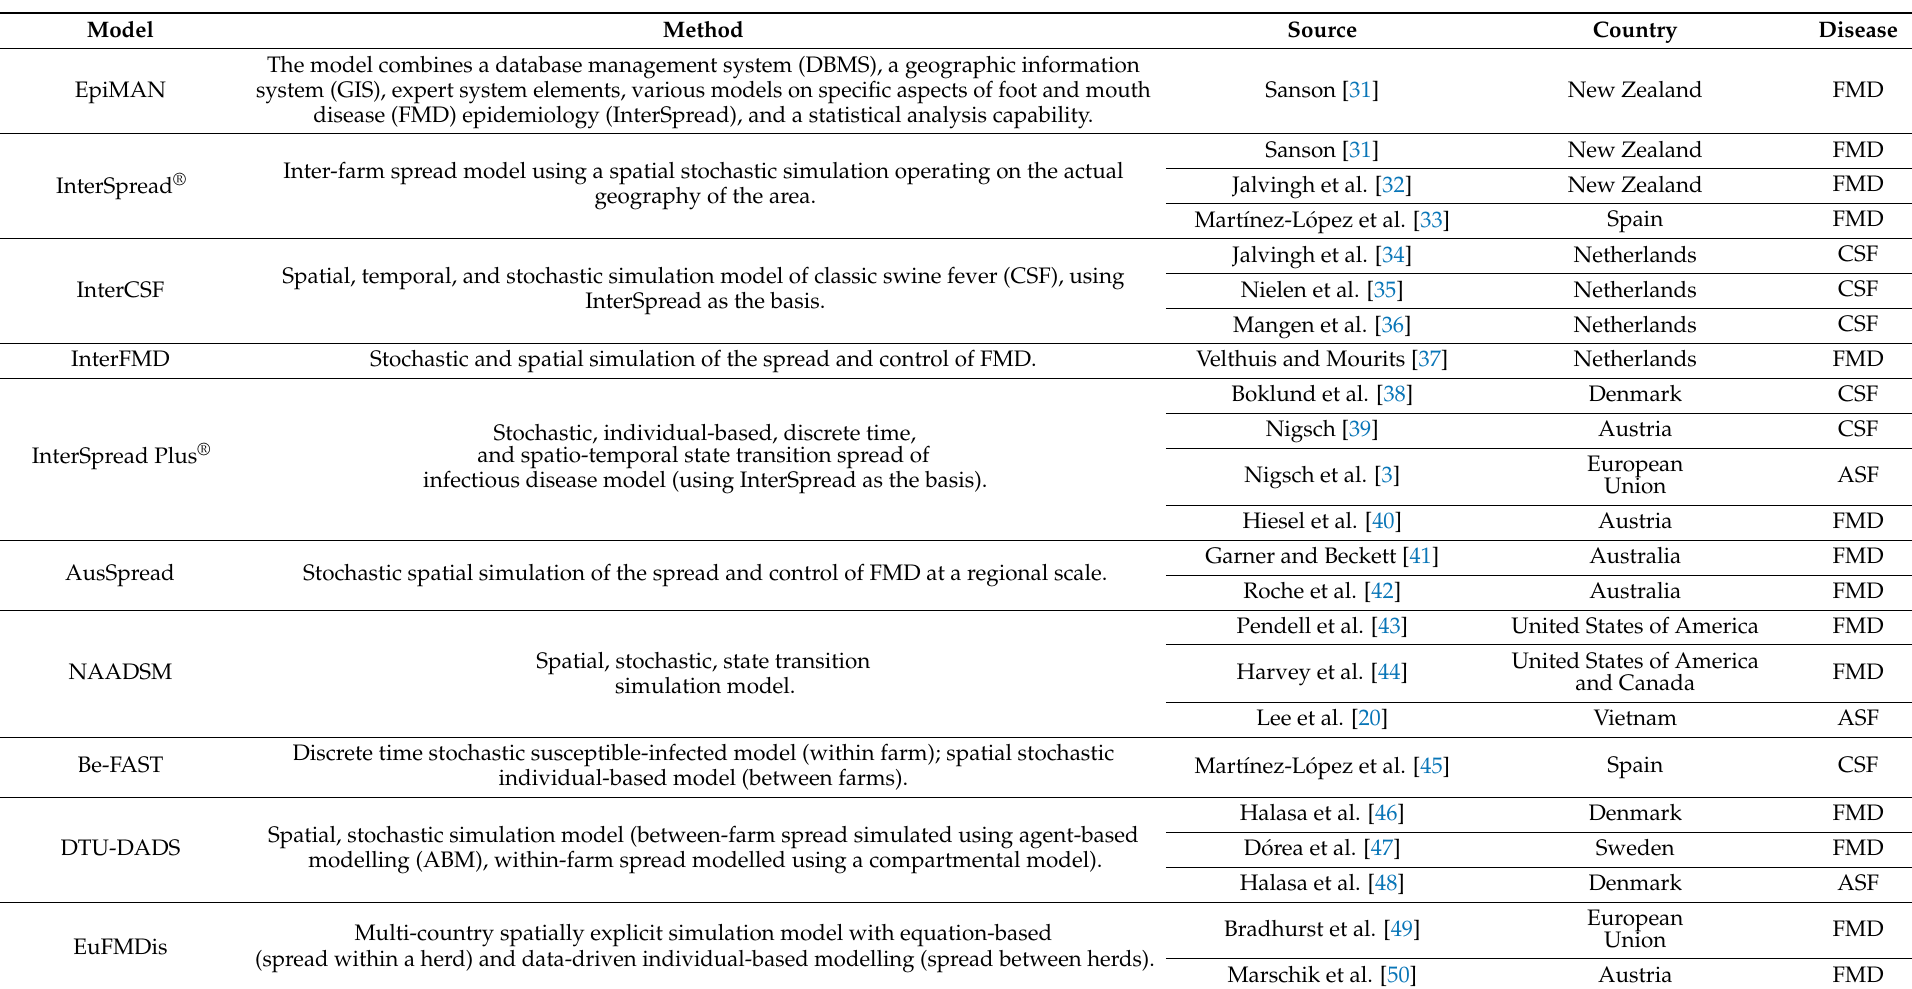
Table 1. Overview of existing models to simulate animal disease spread in different